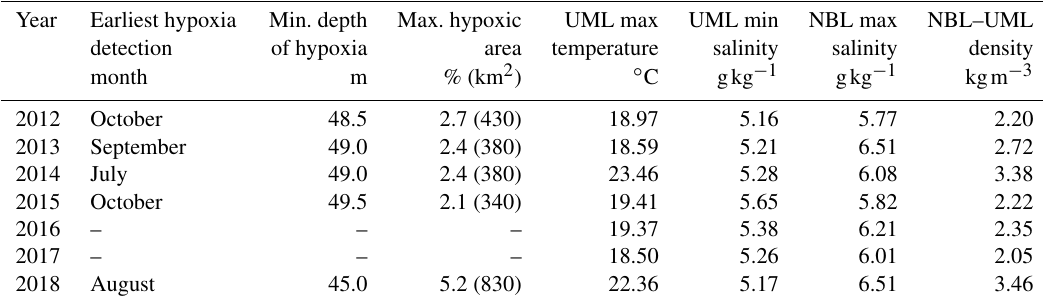
Table 1. Characteristics of seasonal hypoxia and stratification parameters in the Gulf of Riga in 2012–2018, based on CTD profiles from May to November at stations G1 and 121. Observed maxima of UML temperature, NBL salinity, and density difference between NBL and UML and minima of UML salinity are